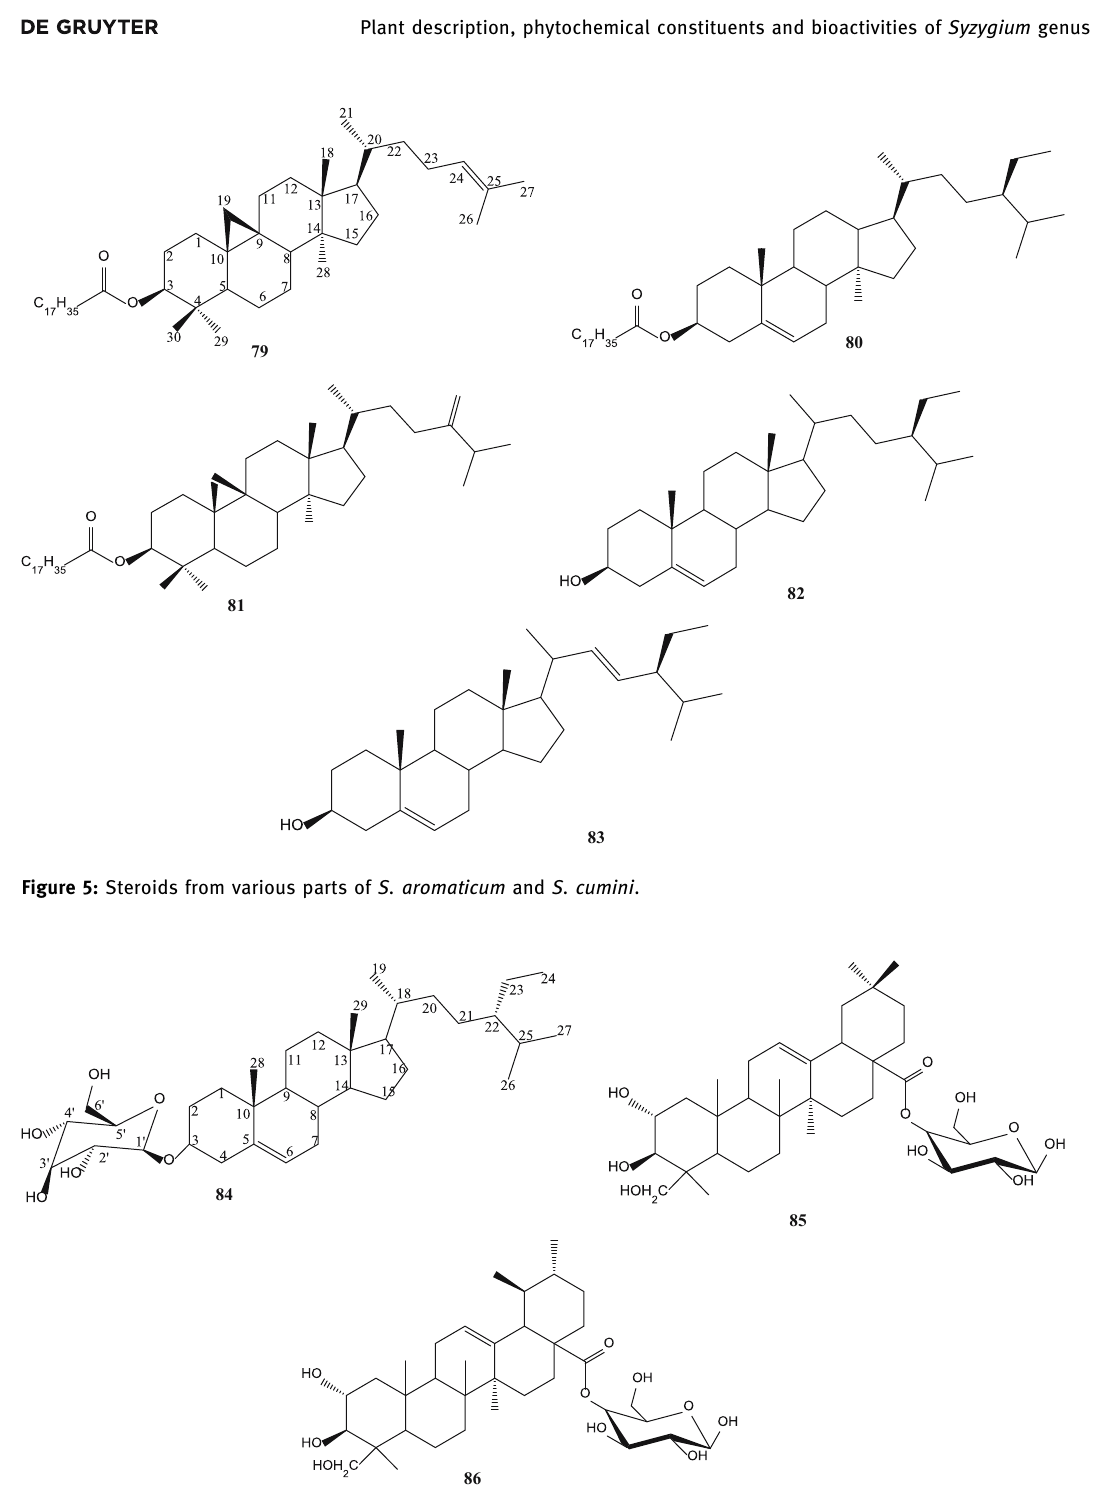
Figure 6: Steroid glycosides and terpenoid glycosides from various parts of S. aromaticum and S. guineense